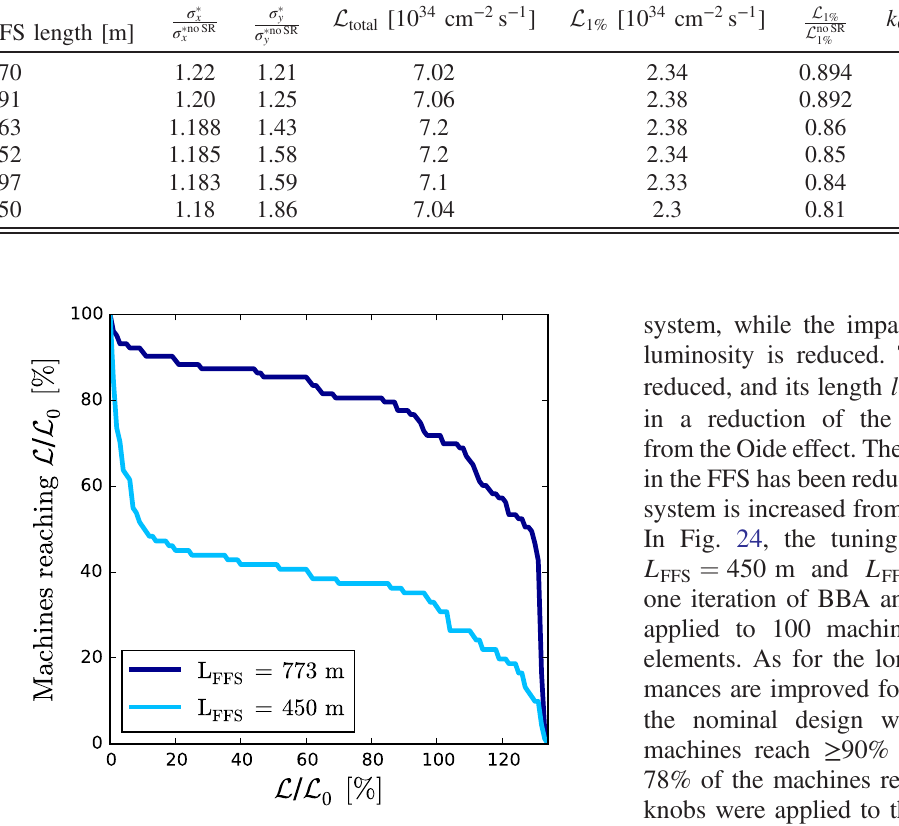
¼ 450 m (nominal design) and FFS